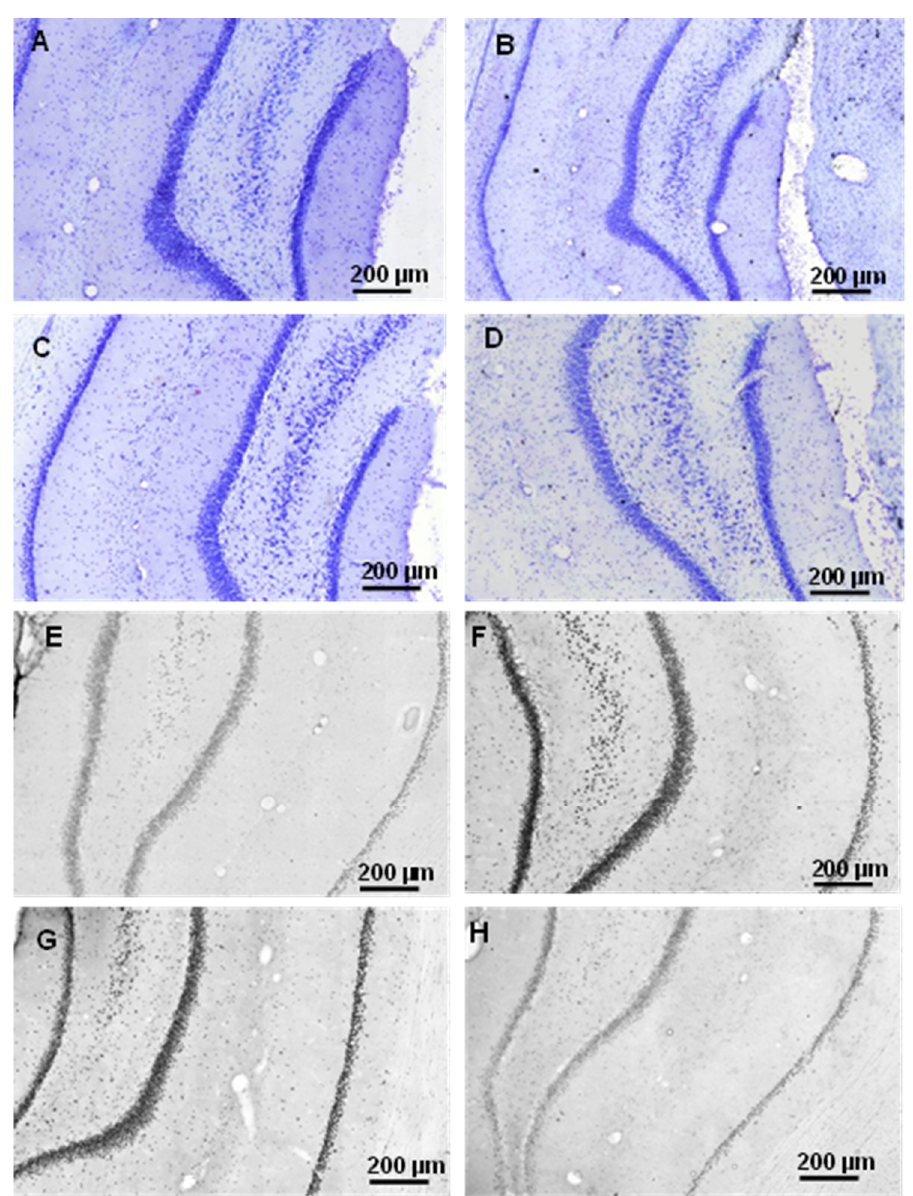
Figure 16. Representative examples of hippocampcal sections in 168 h aggregation time groups using cresyl-violet staining to show the decrease of viable neuron number ( A – D ). Immunochemistry with tau-antibodies shows the increase of abnormally aggregated NFTs ( E – H ). ( A , E ): control group; ( B , F ): 25 μ M concentration; ( C – G ): 75 μ M concentration; ( D – H ): 200 μ M concentration.